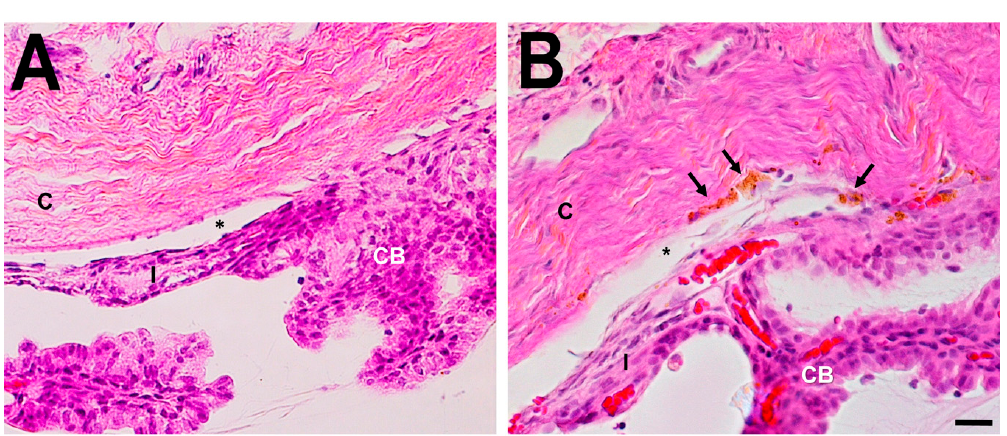
Figure 5. Histological examination of the anterior chamber angle two weeks after polidocanol injection. ( A ) Light microscopy of hematoxylin-eosin staining sections of the iridocorneal angle from an uninjected left control eye illustrating normal histology of trabecular meshwork area. ( B ) Angle from an experimental eye shows the presence of macrophages (arrows) on the trabecular meshwork area. Anterior chamber (*), cornea (C), ciliary body (CB) and iris root (I). Scale bar 20 µm. Retinal microstructure was analyzed by means of the OCT. At both week 2 and week 12, we did not observe any significant reduction in RNFL + GCL + IPL thickness (73.13 ± 3.46 µm) in the hypertensive eyes compared to the control eyes (74.52 ± 0.62 µm) (repeated measures ANOVA, n = 17, p > 0.05). Moreover, whole retina (194.98 ± 10.93 µm), ONL (49.49 ± 4.08 µm) and INL thicknesses (17.23 ± 1.44 µm) in the hypertensive eyes were not significantly different from the fellow control eyes’ whole retina (191.40 ± 10.93 µm), ONL (51.72 ± 5.07 µm) and INL thickness values (18.21 ± 0.87 µm) (repeated measures ANOVA, n = 17, p > 0.05).